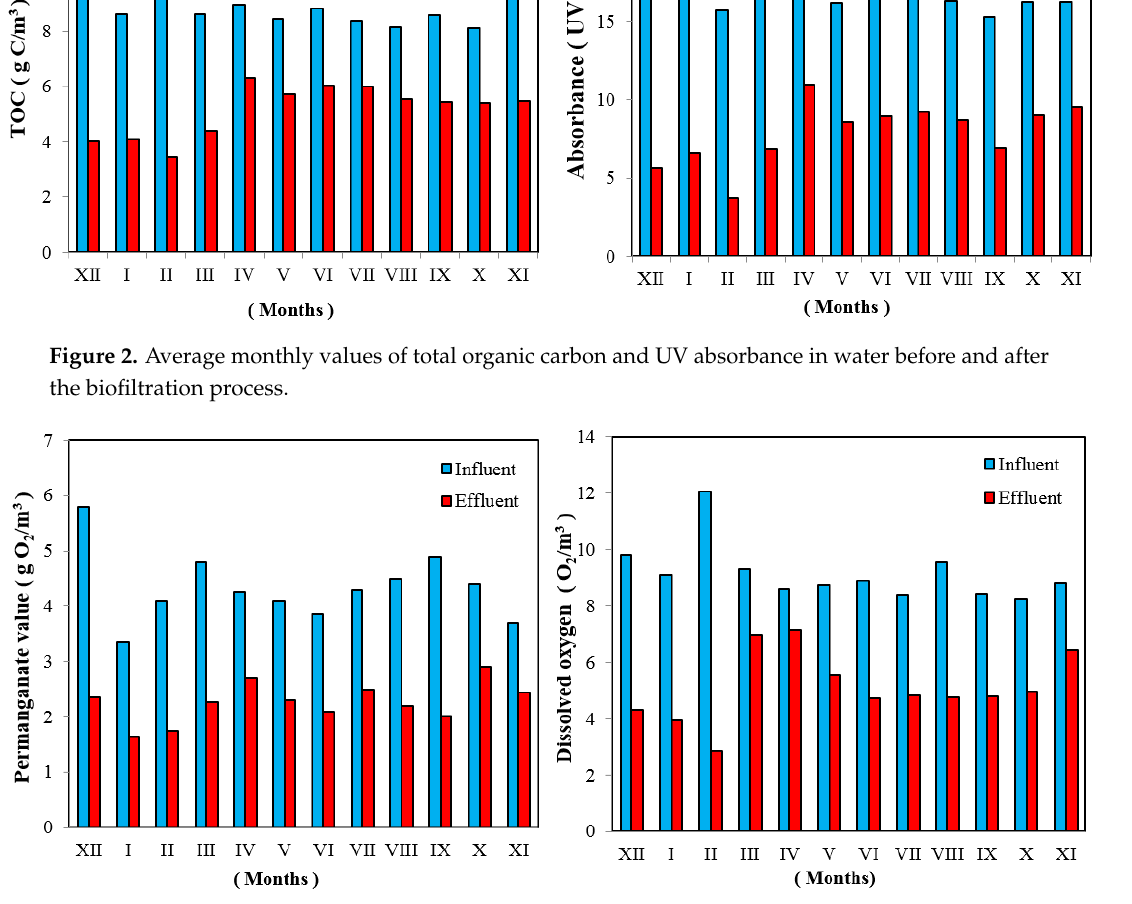
Figure 3. Average monthly values of permanganate value and dissolved oxygen in water before and after the biofiltration process.